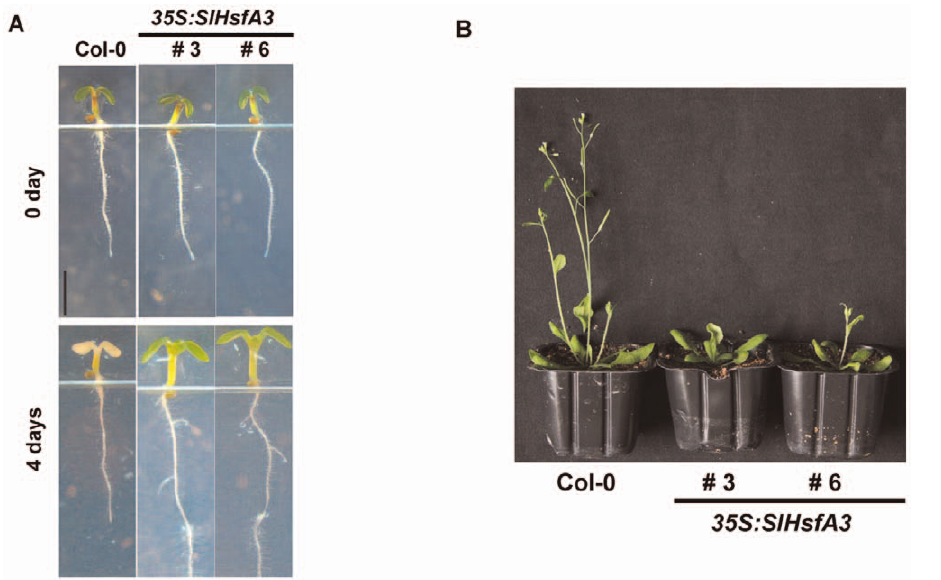
Figure 6. A detailed study of the enhanced thermotolerance brought by SlHsfA3 and the flowering phenotypes of two SlHsfA3 OE lines. (A) The detailed morphology of seedlings of Col-0 and two OE lines at 0 or 4 d after HS treatment. In this case, plants were grown vertically. Bar=2.5 mm. (B) Col-0 and two SlHsfA3 OE lines were grown under the same conditions as described in Methods. The image of four-week-old plants was taken on the same